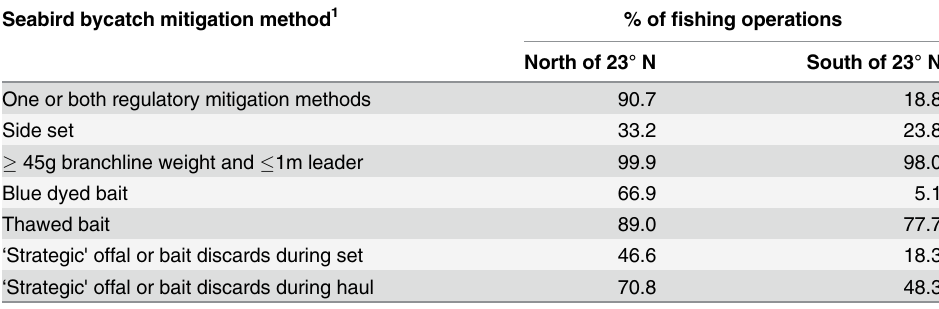
Table 4. Percent of fishing operations (one operation being a set, soak and haul of the gear) where sets began north or south of 23° N. where different seabird bycatch mitigation methods were employed, observer program data, Hawaii deep-set pelagic longline tuna fishery, 17 October 2004 to 19 May 2014. Seabird bycatch mitigation method 1 % of fi shing